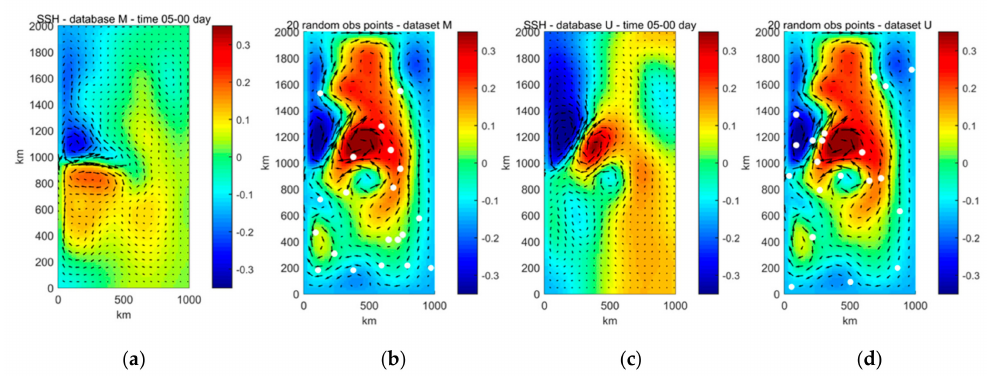
Figure 6. Vector maps of the analysis from the configuration network “M” ( a ) and “U” ( c ) at the end of the assimilation window (see Figure 5). The observation positions, taken from the Nature Run (NR), are represented in ( b ) (Dataset “M”) and ( d ) Dataset “U”).